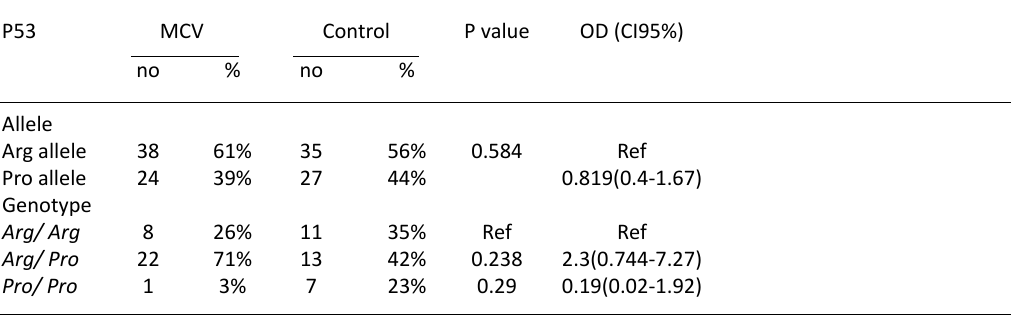
Table 1. Allele and genotype frequencies for P53 gene (Arg/ Pro) polymorphisms among Molluscum contagiosum positive patients and healthy (uninfected controls)